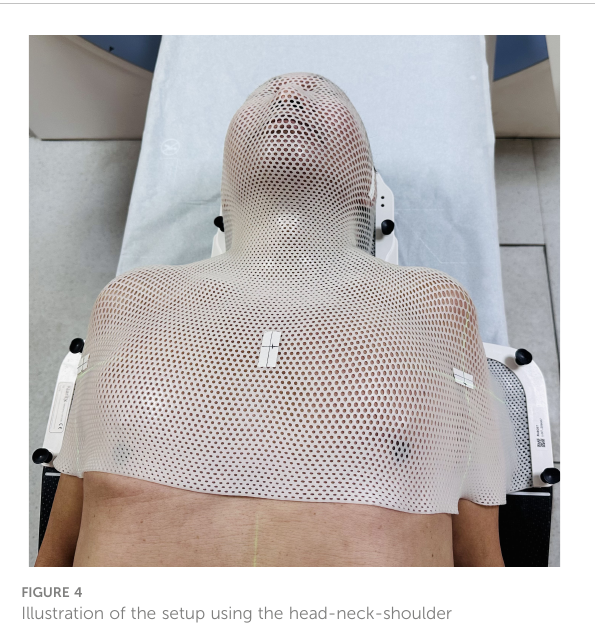
FIGURE 4 Illustration of the setup using the head-neck-shoulder immobilization device